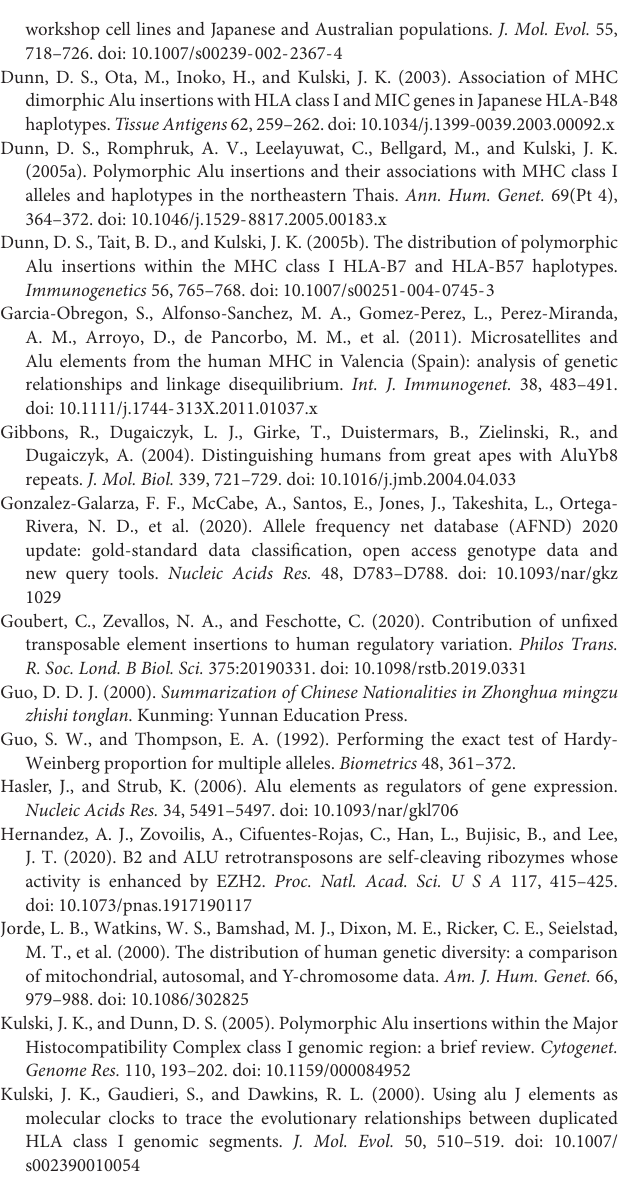
representations of Curated RefSeq, gene expression profile from GTEx RNA-seq, ENCODE cCREs, and Repeat Elements by RepeatMasker and labeled to show the positions of the AluDRB1 and AluDQA1 insertions along the SINE row. Supplementary Figure 2 | The Electrophoresis results for different sized PCR products of Five MHC POALINs. The POALIN alleles are dimorphic structures whereby the absence of the Alu insertion at the Alu locus is the Alu ∗ 1 allele and the presence of the Alu insertion is the Alu ∗ 2 allele. 1: the PCR products of AluORF10 1, 1; 2: the PCR products of AluORF10 1, 2; 3: the PCR products of AluORF10 2, 2; 4: the PCR products of AluDQA1 2, 2; 5: the PCR products of AluDQA1 1, 2; 6: the PCR products of AluDQA1 1, 1; 7: the PCR products of AluDPB2 2, 2; 8: the PCR products of AluDPB2 1, 2; 9: the PCR products of AluDPB2 1, 1; 10: the PCR products of AluDRB1 1, 1; 11: the PCR products of AluDRB1 1, 2; 12: the PCR products of AluDRB1 2, 2; 13: the PCR products of AluDQA2 1, 1; 14: the PCR products of AluDQA2 1, 2; 15: the PCR products of AluDQA2 2, 2; M1: 1000bp Marker; M2: 2000bp